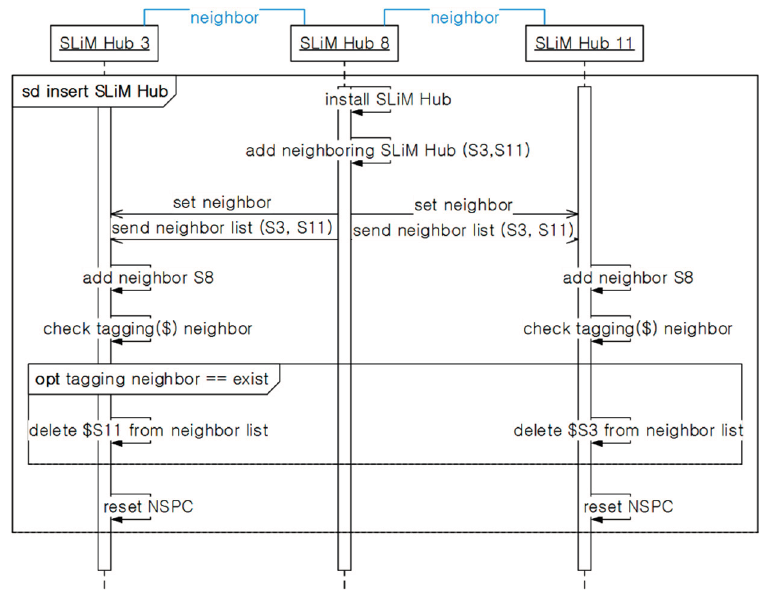
Figure 13. The sequence for installing or reinstalling a SLiM Hub.